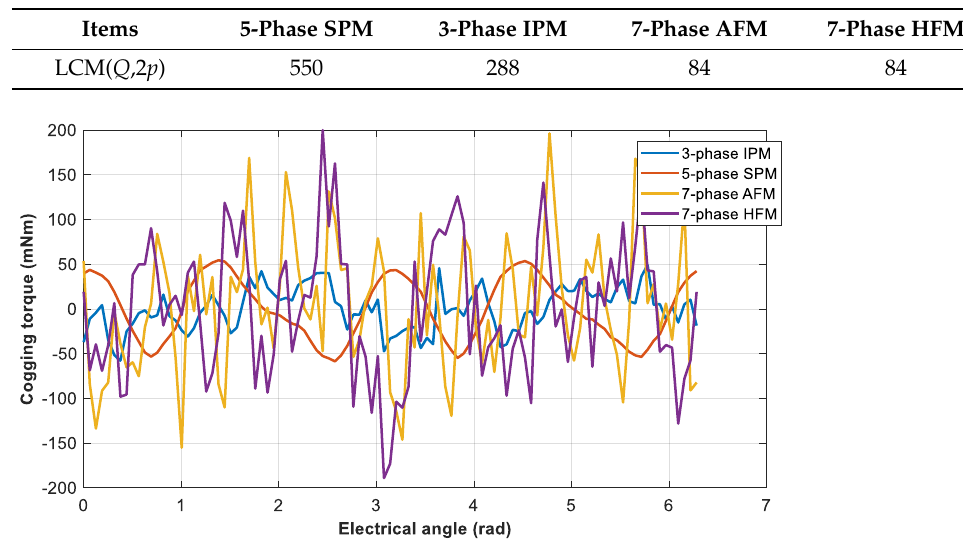
Table 2. LCM of the four machines. Figure 7. EMFs and spectrum harmonics of ( a ) three − phase IPM; ( b ) five − phase SPM; ( c ) seven − phase AFM; ( d ) seven − phase HFM.